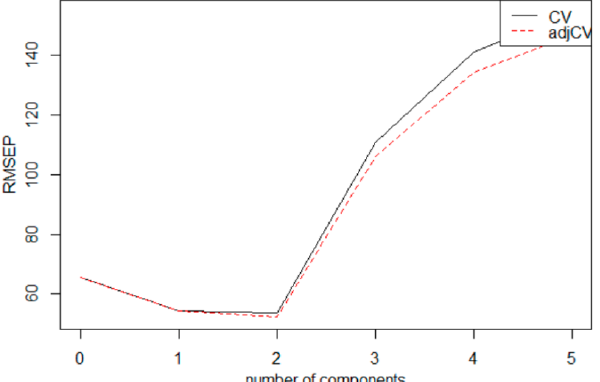
negative correlation. Cyan, green and yellow show low or no correlation between the variables. Water 2020 , 12 , x FOR PEER REVIEW 19 of 23